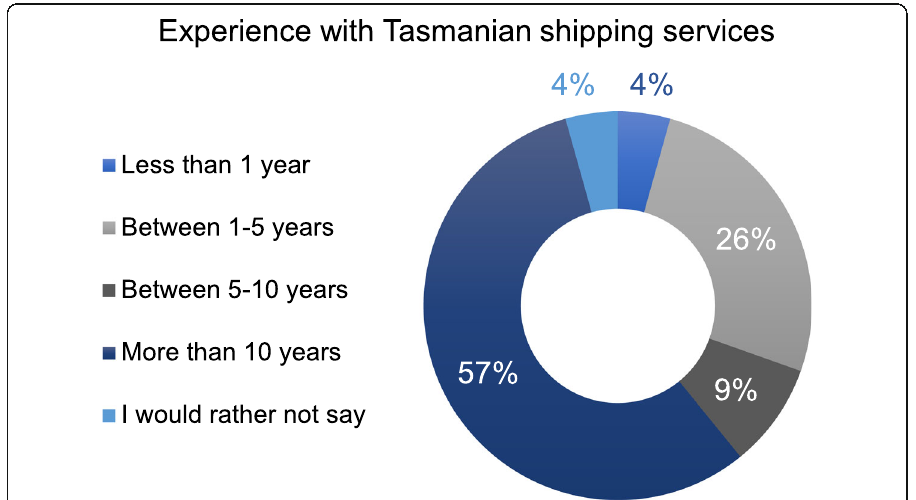
Fig. 3 Percentage breakdown of experience with Tasmanian shipping